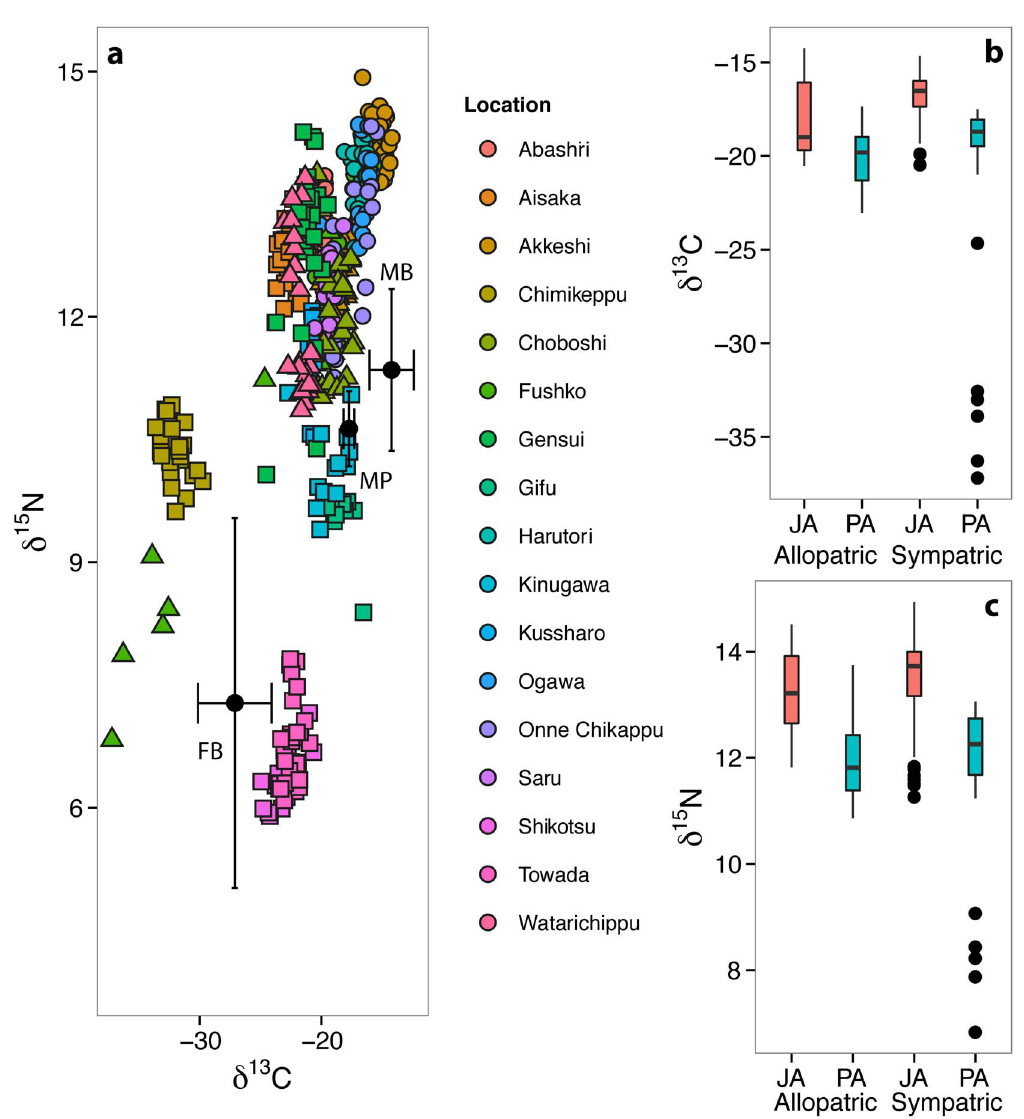
Figure 4. d 13 C and d 15 N isotope biplot (a) showing Japan Sea (circles), Pacific Ocean (triangles) and Pacific freshwater populations (squares; note, individuals from Fushikobetsu not shown to aid interpretation) with putative dietary source values (mean % ¡ SD); boxplots (b and c) representing differences in d 13 C and d 15 N values between allopatric and sympatric JA and PA populations.